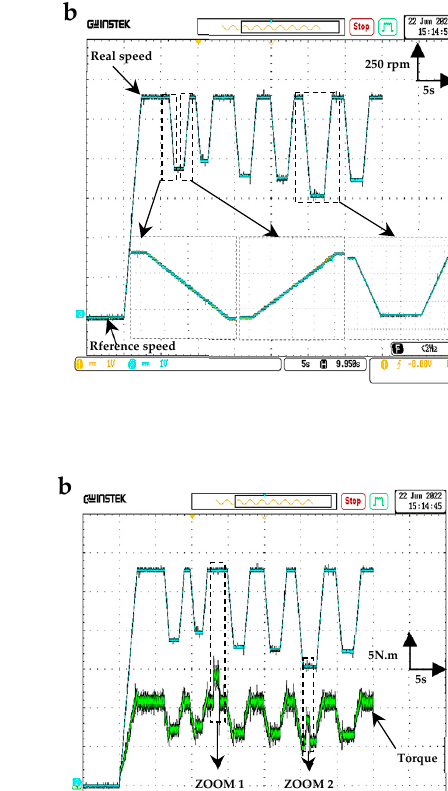
Figure 18. Electromagnetic torque and speed response for speed profile 1 and 2.